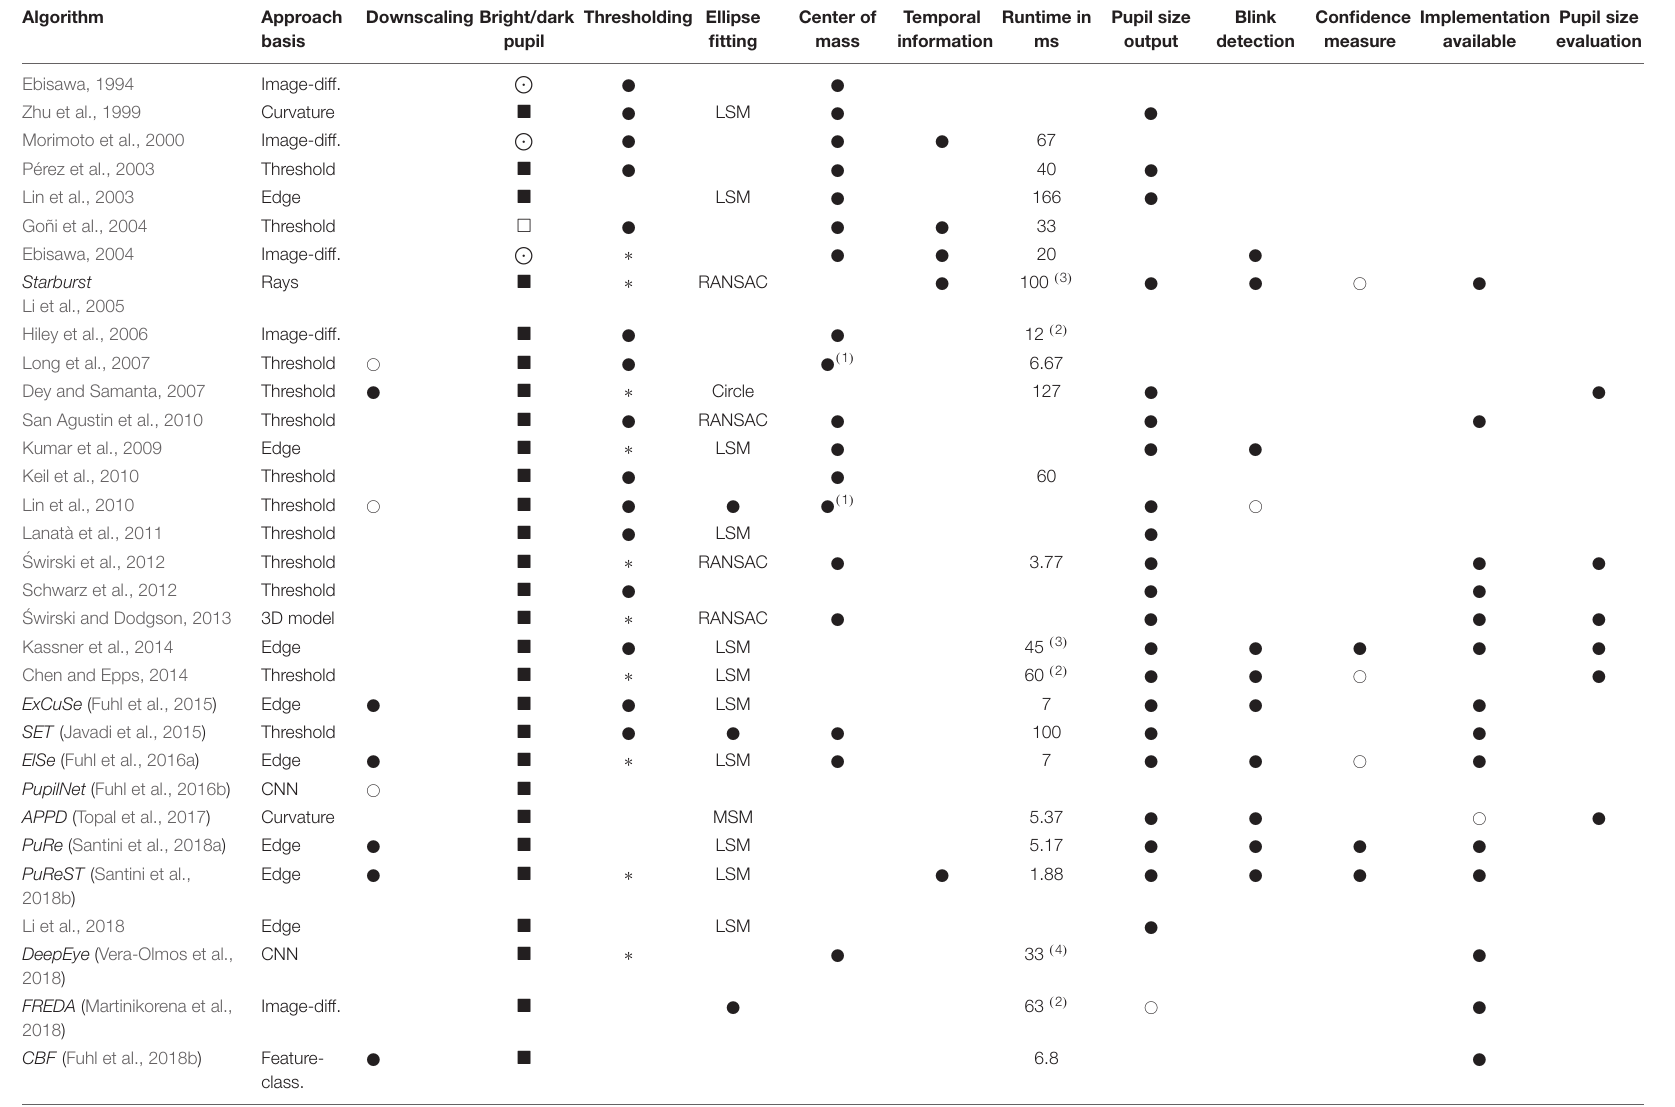
TABLE 1 | Comparison of the pupil detection algorithms identified in the literature.